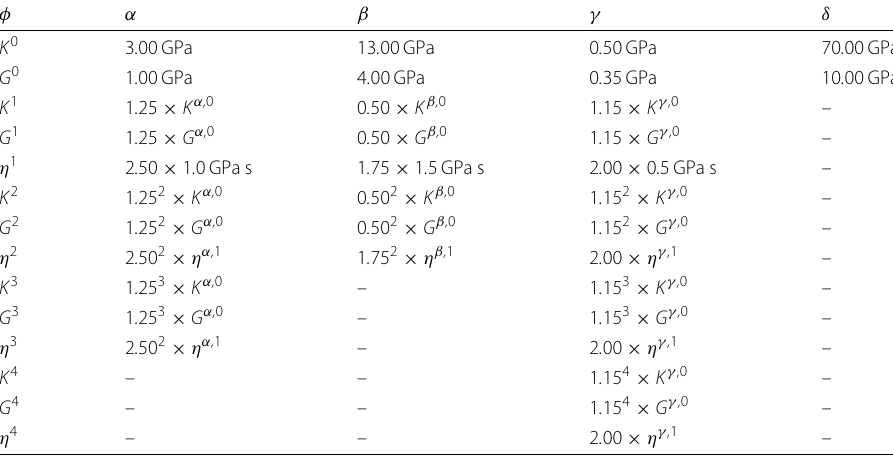
Table5 Four phases, straight and curved interfaces: Material